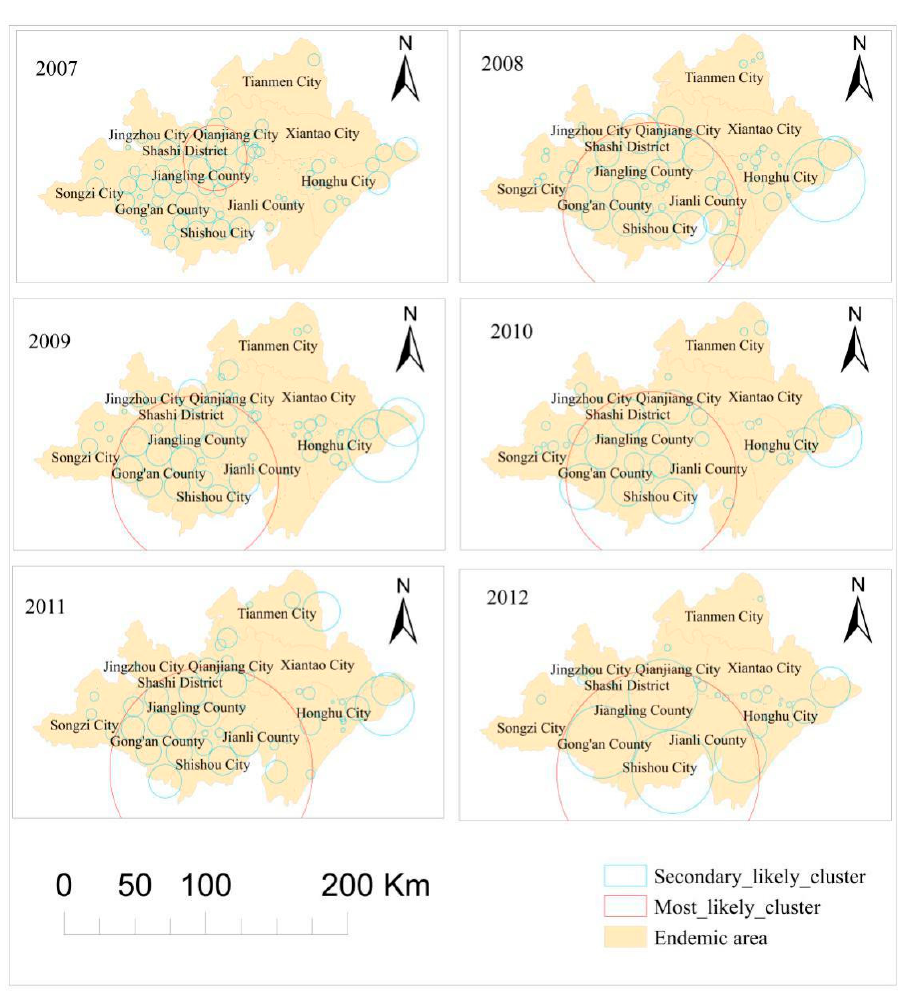
Figure 2. Spatial clusters detected by utilizing the discrete Poisson model from 2007 to 2012 in Jianghan Plain. Table 1. Spatial analysis scanning for clusters with large populations of schistosomiasis infections using Kulldorff’s spatial scan statistic.